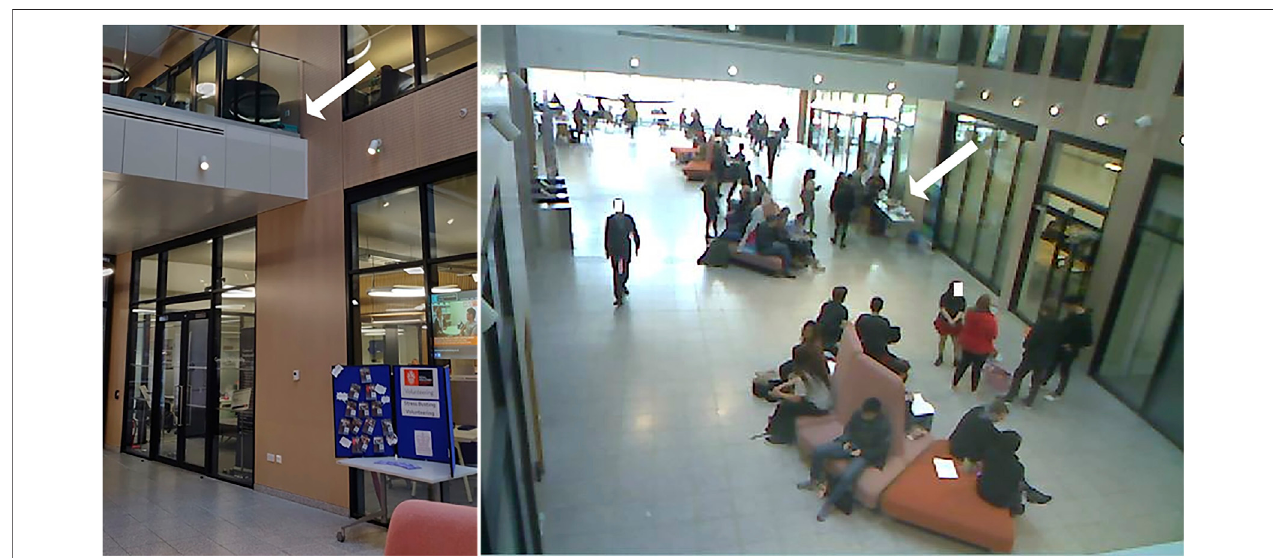
FIGURE 9 | consisting of two photos. The photo on the left shows the position of the webcam (see white arrow) that recorded people traf fi c, which was mounted approximately 6 m above fl oor level on an alcove. The photo on the right, taken by the webcam, shows the position of the table (see white arrow) upon which the headsets available to participants in the other study were located. Detectable faces were automatically painted over with white boxes in this photo. The resolution of the photo in the fi gure has been reduced to bolster anonymity.